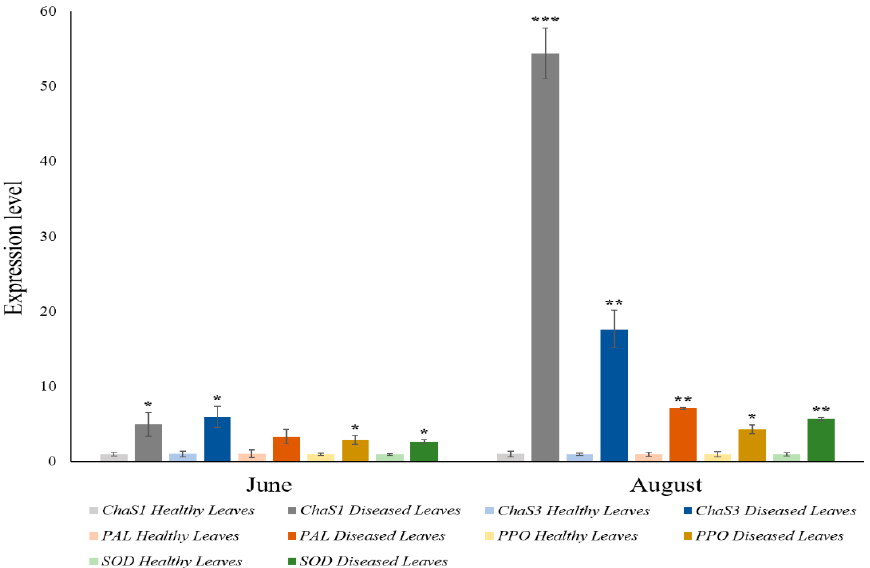
Figure 4. Transcript accumulation in grapevine healthy leaves vs. esca-diseased leaves, from June and August. Quantitative PCR in ChaS, ChaS3, PAL, PPO, and SOD of both types (healthy and esca-diseased plants) to quantify ChaS , ChaS3 , PAL , PPO , and SOD transcripts. Significant differences by Student’s t -test between each transgenic line and Col-0 are marked (* p < 0.05; ** p < 0.05 ∩ p ≥ 0.001; *** p < 0.001).